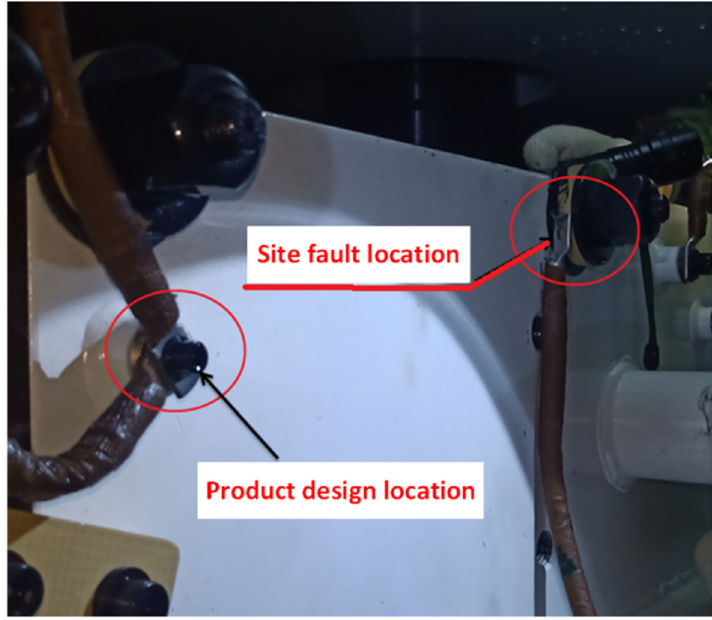
Figure 10. Discharge traces in the power reactor.